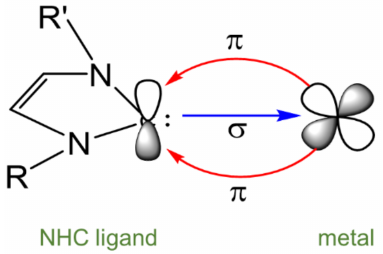
Figure 2. σ and π interactions of an NHC and a transition